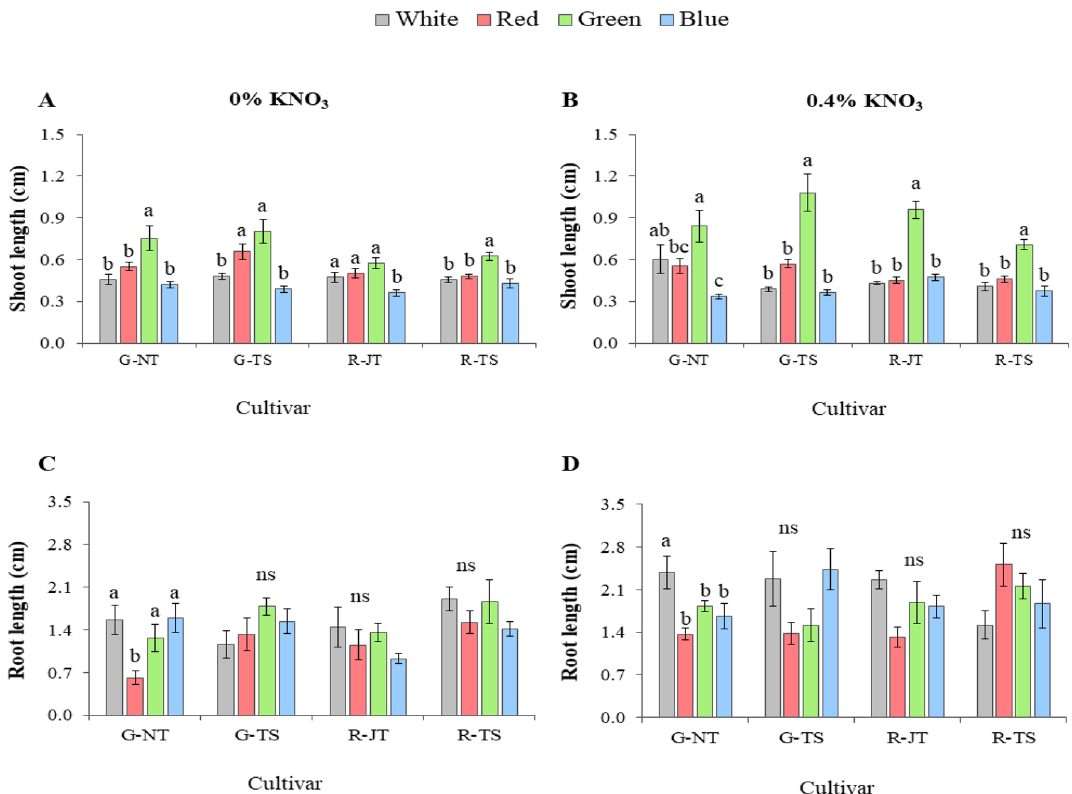
Figure 3. Shoot height ( A , B ) and root length ( C , D ) of four holy basil varieties from three companies; G-NT, G-TS, R-JT and R-TS treated with difference light treatments under 0% and 0.4% KNO 3 concentrations at 15 days after sowing. Different letters above bars indicate significant differences among light treatments on the same brand at P < 0.05. “ns” indicates no significant difference. Data are mean values (n = 4) ± SE.